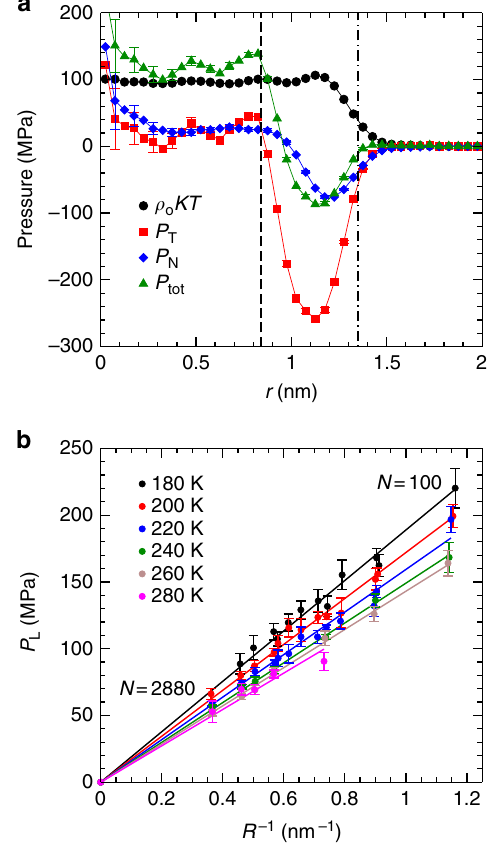
Fig. 7 Laplace pressure inside nanodroplets. a Contributions to the pressure inside a water nanodroplet as a function of r , for N = 360 and T = 200 K. Vertical lines identify r = R L (dashed) and r = R (dot-dashed). b Isotherms of P L as a function of R − 1 . Note that N decreases with R − 1 along each isotherm. The point at the origin is the expected value of P L for droplets as R → ∞ . The straight lines are fi ts of the Young-Laplace equation P to the data along each isotherm. The error for R − 1 is smaller than the symbol size; the error in P L represents one standard deviation of the